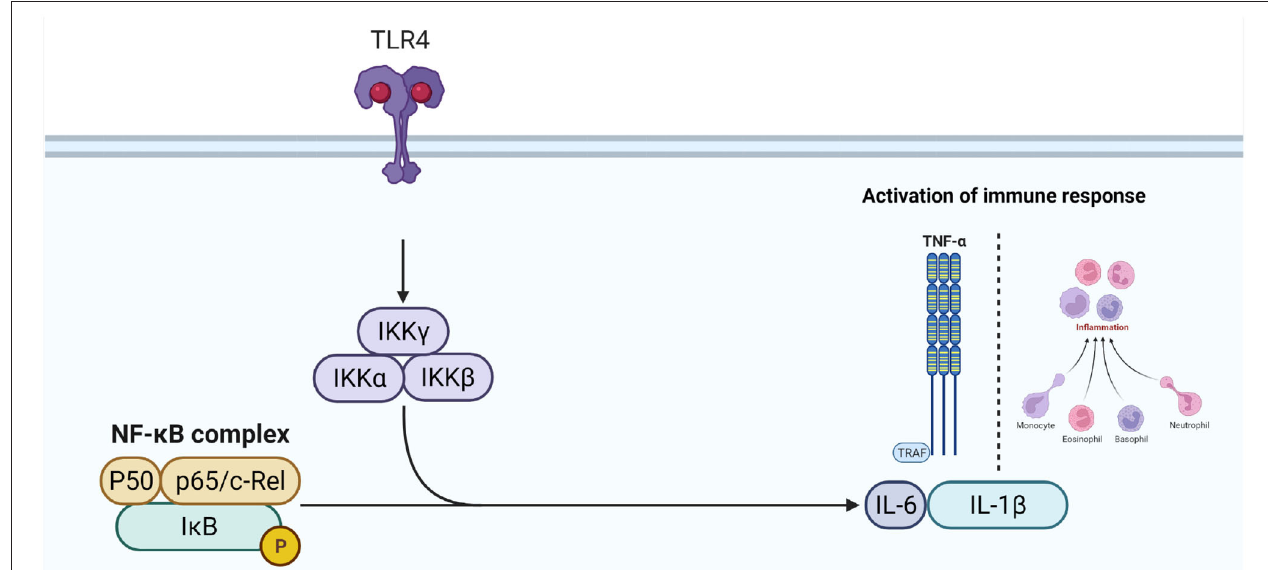
FIGURE 7 | Mechanism insight of Manuka honey in the activation of inflammatory